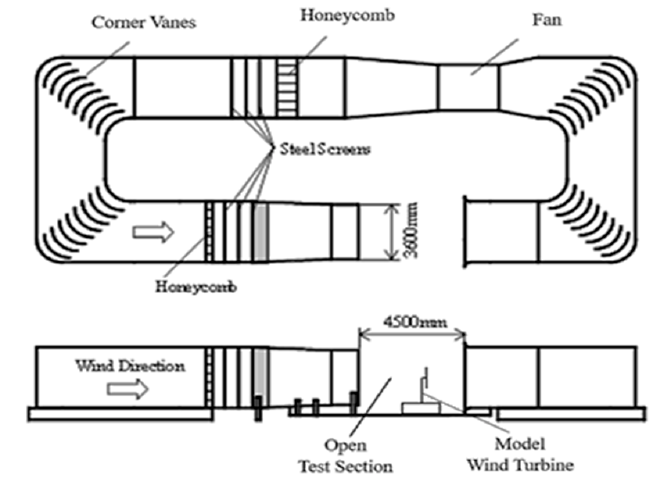
Figure 1. An overall diagram of the wind tunnel for the experiment.